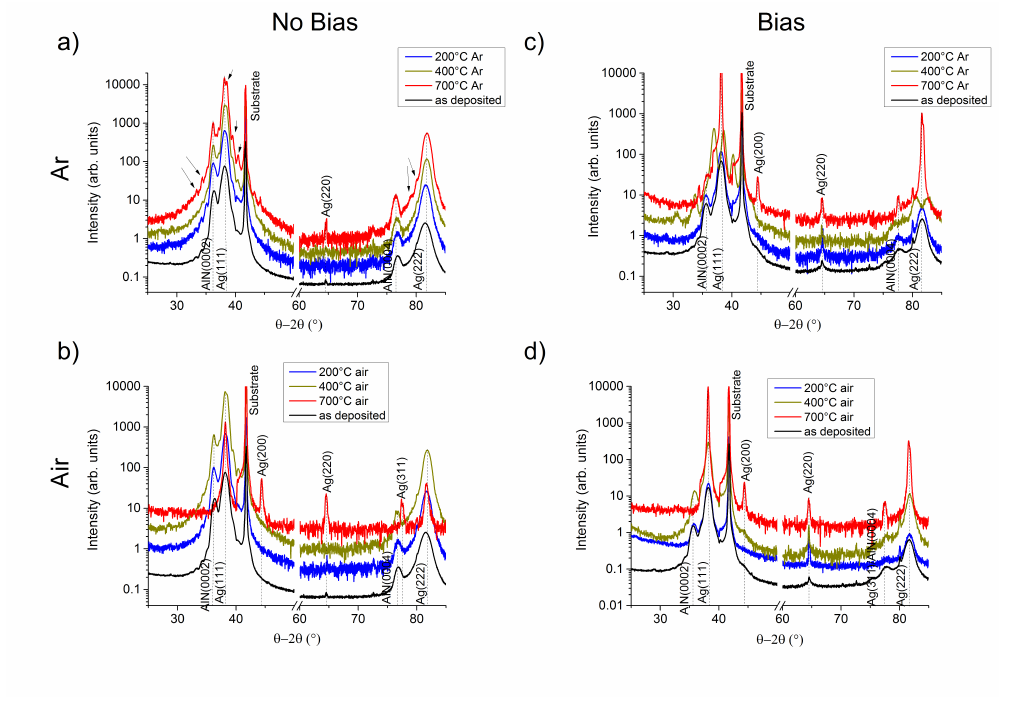
Figure 4. XRD scans of samples annealed at different temperatures for bias and non-bias samples, annealed in Ar ( a , c ) and in air ( b , d ), respectively. The arrows in ( c ) indicate the satellite appeareance pointing out a smoother interface upon